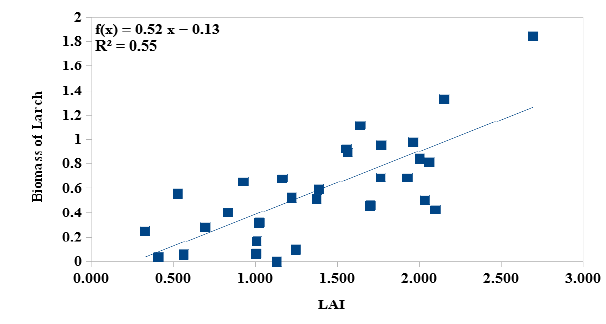
Figure 6. Relationship between the LAI and the Biomass of Larch wood